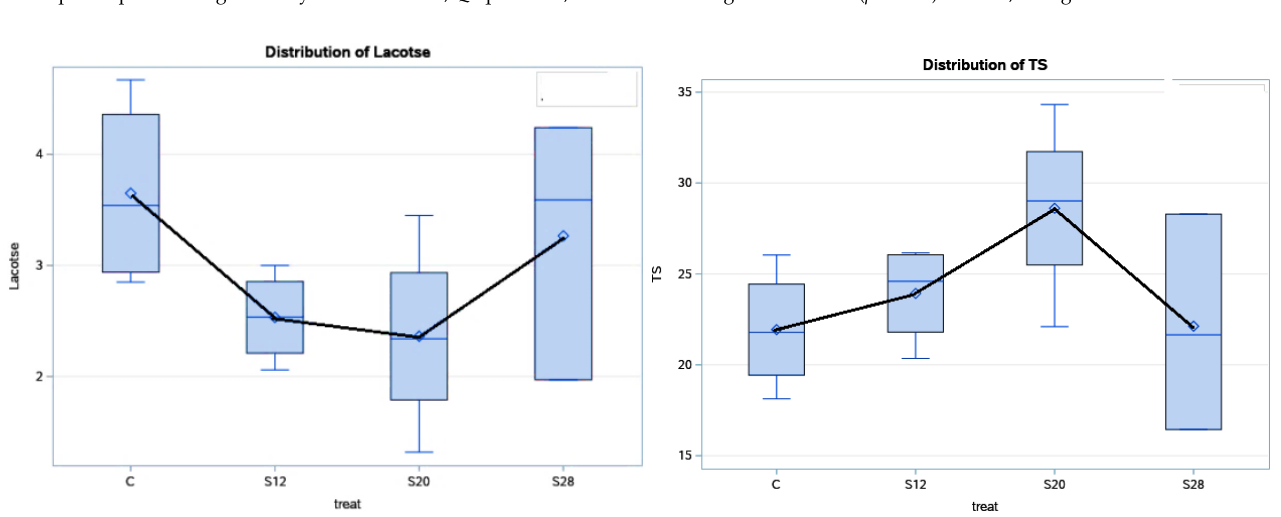
Table 4. The effect of different levels of sunflower hulls on the colostrum composition, as assessed 48 h postpartum. Variable